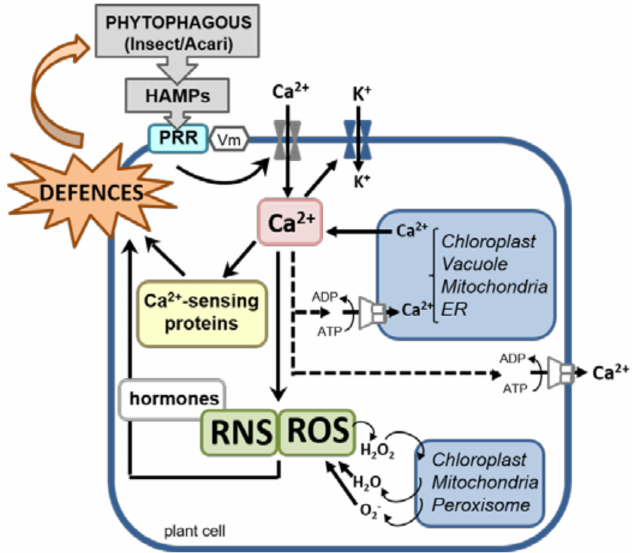
Figure 3. Early plant events in plant–phytophagous pest interactions. Specific plant receptors (PRRs) recognize elicitors/effectors (HAMPs) derived from either the plant or the phytophagous pest side (insects and acari) that induce alterations in the membrane potential (Vm) and cytosolic Ca 2+ influxes from the apoplast and organelles. Subsequently, Ca 2+ -sensing proteins are activated and reactive oxygen species (ROS) and reactive nitrogen species (RNS) burst is triggered. Then cytosolic Ca 2+ concentration is restored via Ca 2+ -ATPases, and finally, in a second step, specific